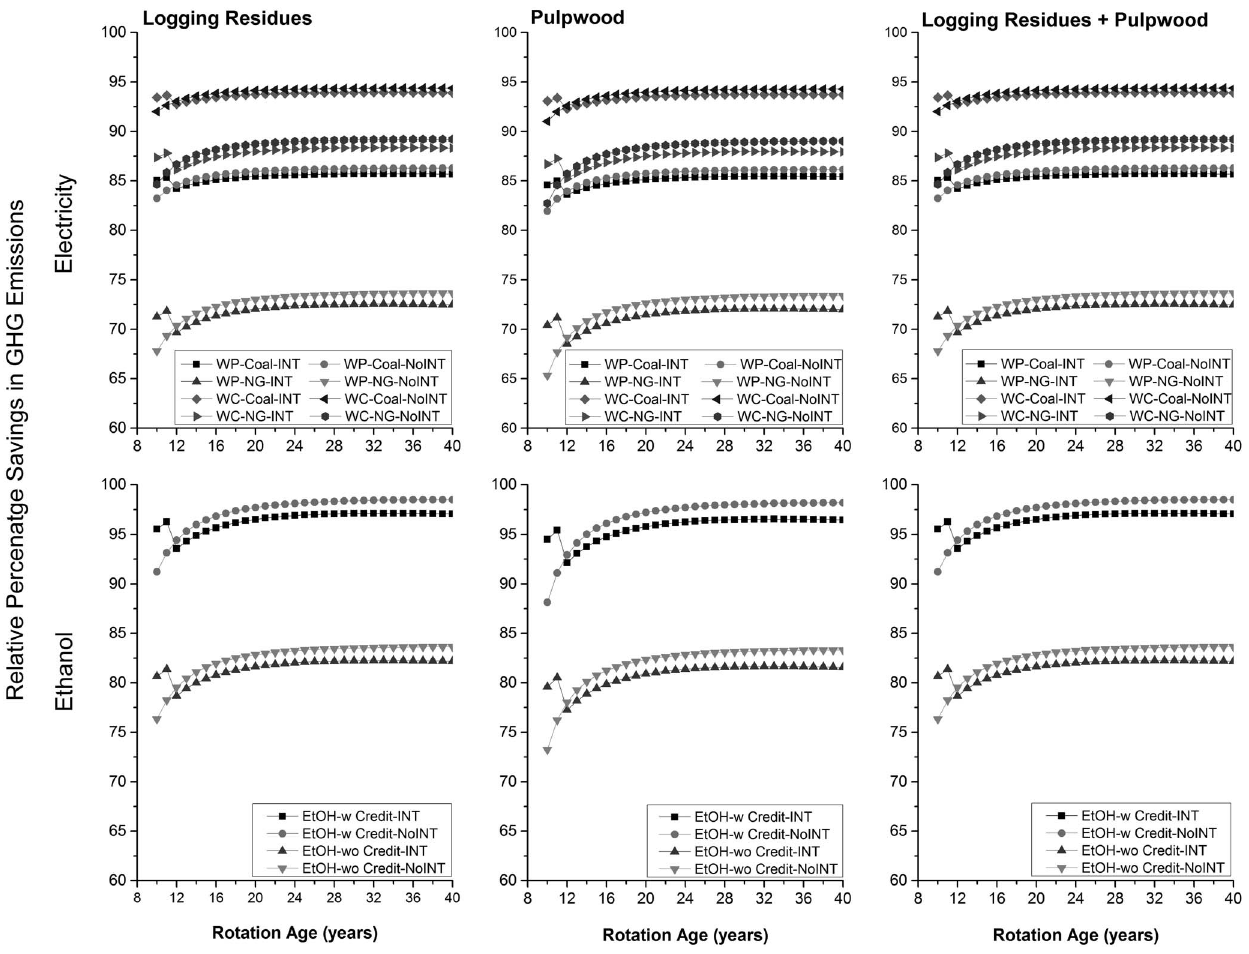
Figure 8. Relative percentage savings in GHG emissions. LR: logging residues; PW: pulpwood; WP: wood pellets; WC: wood chips; w: with income from cogenerated electricity; wo: without income from cogenerated electricity.